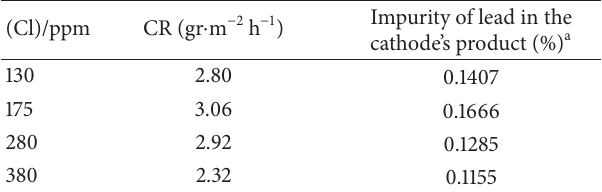
Table 1: Corrosion rate (CR) of the lead/silver, measured gravimet- rically in zinc electrowinning solutions containing different chloride concentrations ( 𝑡 = 72 hr, 𝑖 = 500 Am − 2 , and 𝑇 = 40 ∘ C).